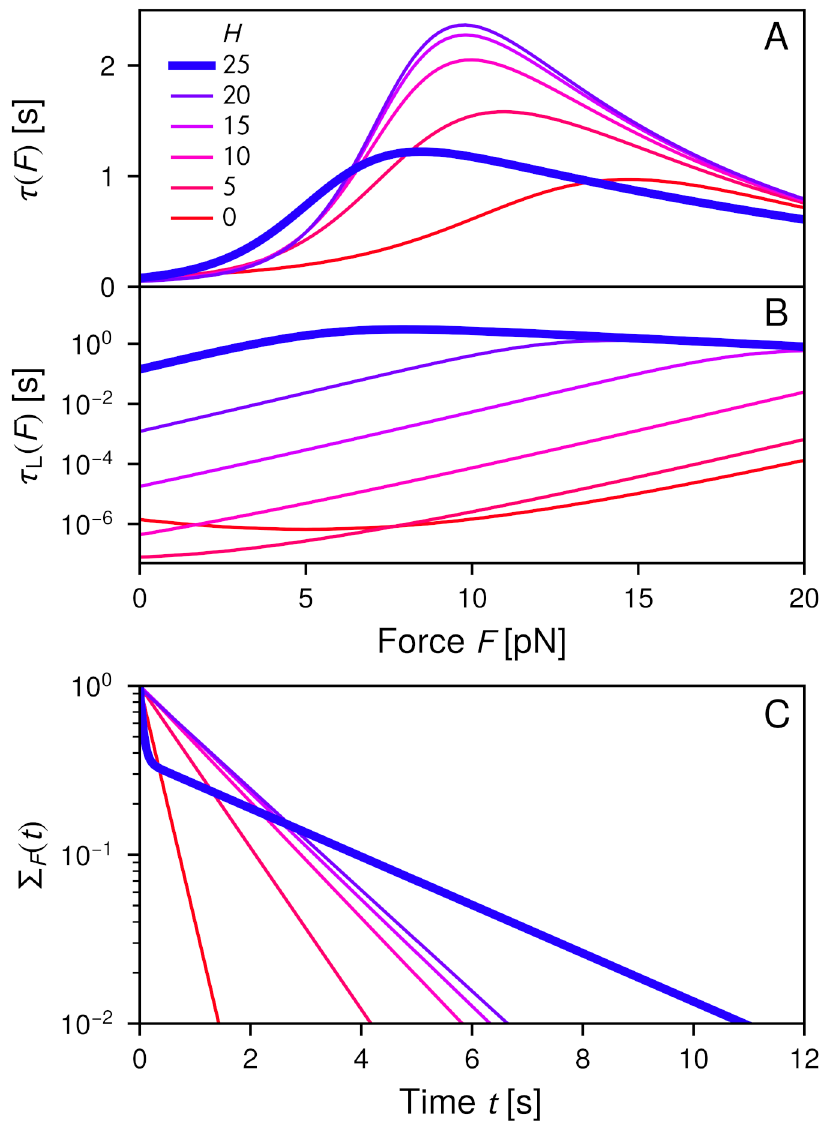
Fig 6. The effects of mutating the angular barrier height H from the original value of 25 k increments of 5 k B T , leaving all other model parameters fixed at their Table 1 values: A) the mean bond lifetime τ ( F ); B) the mean lifetime τ L ( F ) of remaining in the large angle conformational state, α > α initial time of entry into the state; C) the survival probability S F ( t ) at F = 7